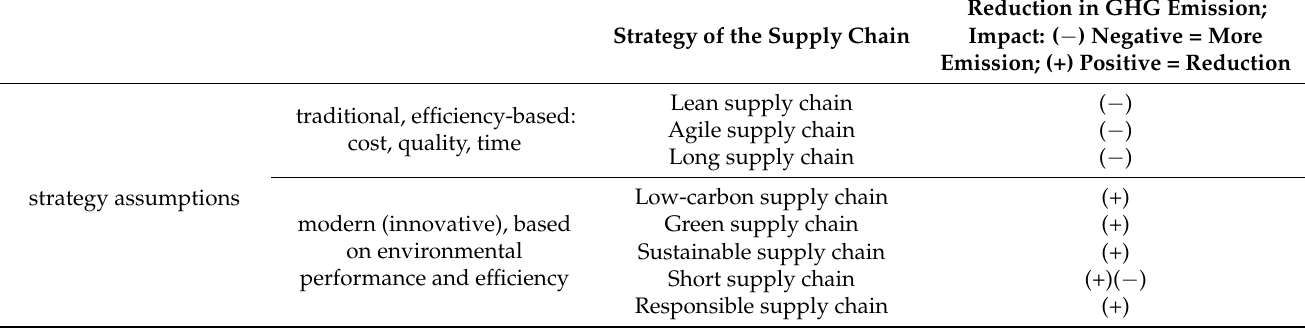
Table 1. GHG impacts of selected supply chain strategies. Reduction in GHG Emission; Strategy of the Supply Chain Impact: ( − ) Negative = More Emission; (+) Positive =